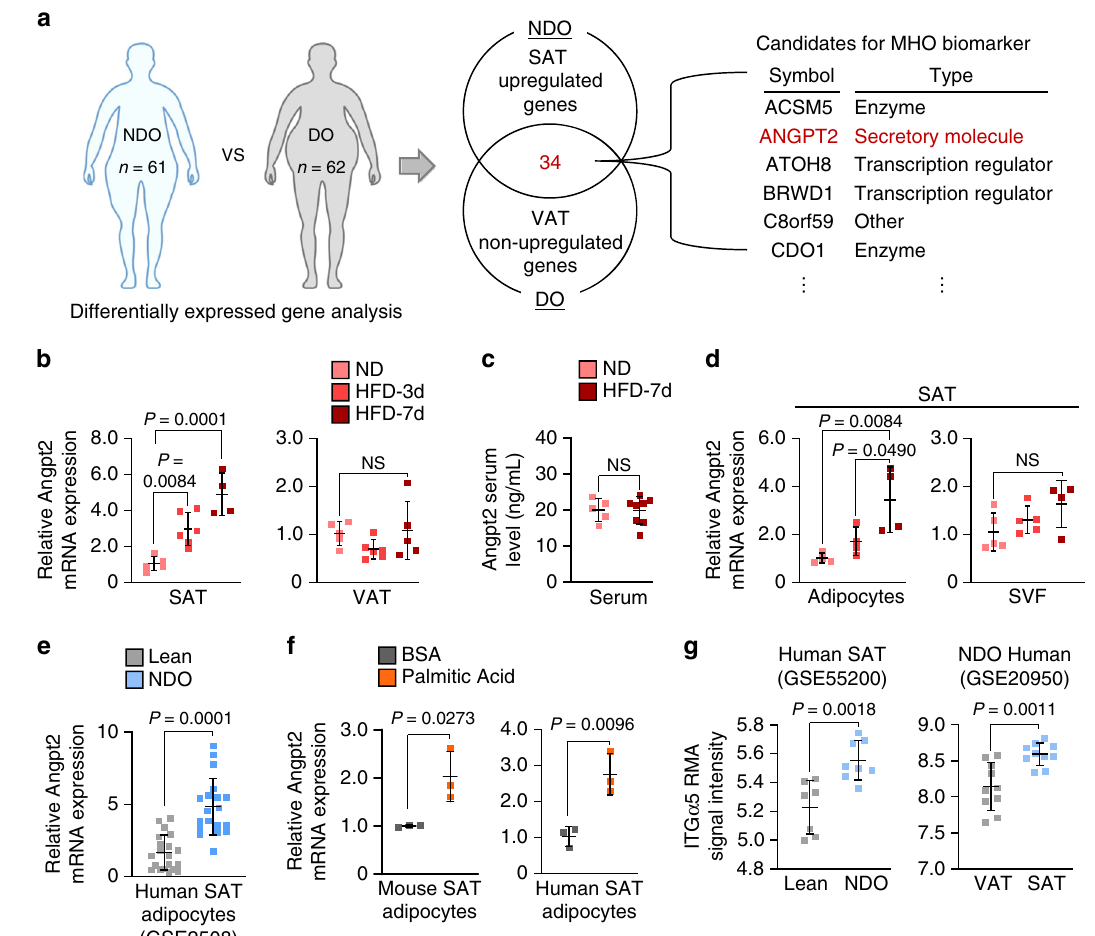
Fig. 8 Angpt2 is preferentially expressed and upregulated in SAT upon lipid intake. a Schematic diagram (left) for comparative transcriptomic analysis (Gene Expression Omnibus) between NDO ( n = 61; nondiabetic obese) and DO ( n = 62; diabetic obese) individuals. Venn diagram analysis (middle) indicating number of genes that are speci fi cally upregulated in SAT (fold change > 1.5, p < 0.05) but not in VAT (fold change < 1.5) in NDO compared with DO individuals. List (right) of candidates among 34 genes that are speci fi cally enriched in SAT of NDO individuals. Details of identi fi ed genes and analyzed gene sets are listed in Supplementary Tables 1, 2. b Comparisons of Angpt2 mRNA expression in SAT and VAT of WT mice fed with HFD for 3 days (HFD- 3d) and 7 days. n = 4 – 6 mice/group pooled from two independent experiments. c Comparison of Angpt2 protein in serum of WT mice fed with HFD